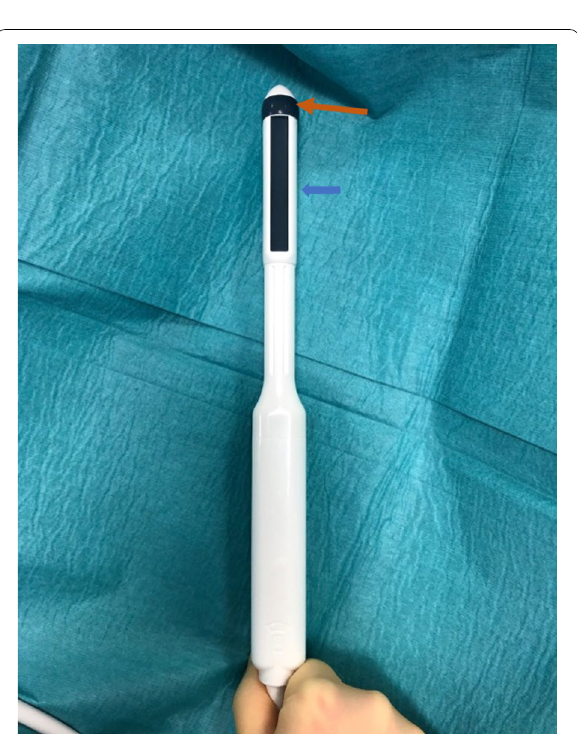
Fig. 2 Hitachi Arietta 65 Ultrasound machine with biplane transrectal probe. The orange arrow represents the axial transducer, and the